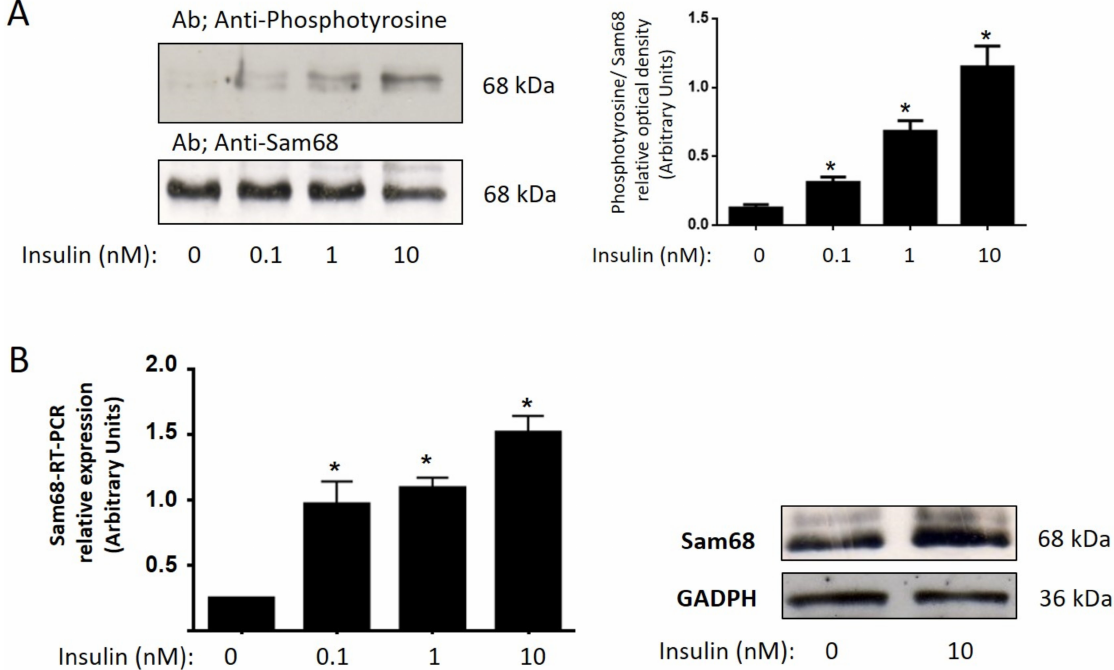
Figure 1. Insulin increases Sam68 phosphorylation in human GCs from healthy donors. ( A ) GCs were incubated in absence or presence of insulin (0.1–10 nM) for 10 min, lysed, and the soluble clarified cell lysates were subjected to immunoprecipitation with anti-Sam68 antibodies. Immuno- precipitates were resolved by SDS-PAGE and Western blot with anti-phosphotyrosine antibodies. The lysates were analyzed by immunoblot using the anti-Sam68 antibodies to control the amount of protein in every lane. Statistical analyses were performed by one-way ANOVA followed by Bonferroni’s multiple comparison post-hoc test. A representative experiment run in duplicates from 3 different donors is shown. Densitograms with SD are shown; * p < 0.05 versus control. ( B ) Total RNA was extracted as described in Section 2, and Sam68 mRNA was quantified with qRT-PCR in independent experiments. Cyclophilin was used as internal standard. Results shown are expressed as means ± SD from three independent experiments, run in triplicates; * p < 0.05 versus control. Statisti- cal analyses were performed by one-way ANOVA. Asterisks indicate significant differences from the control according to Bonferroni’s multiple comparison post-hoc